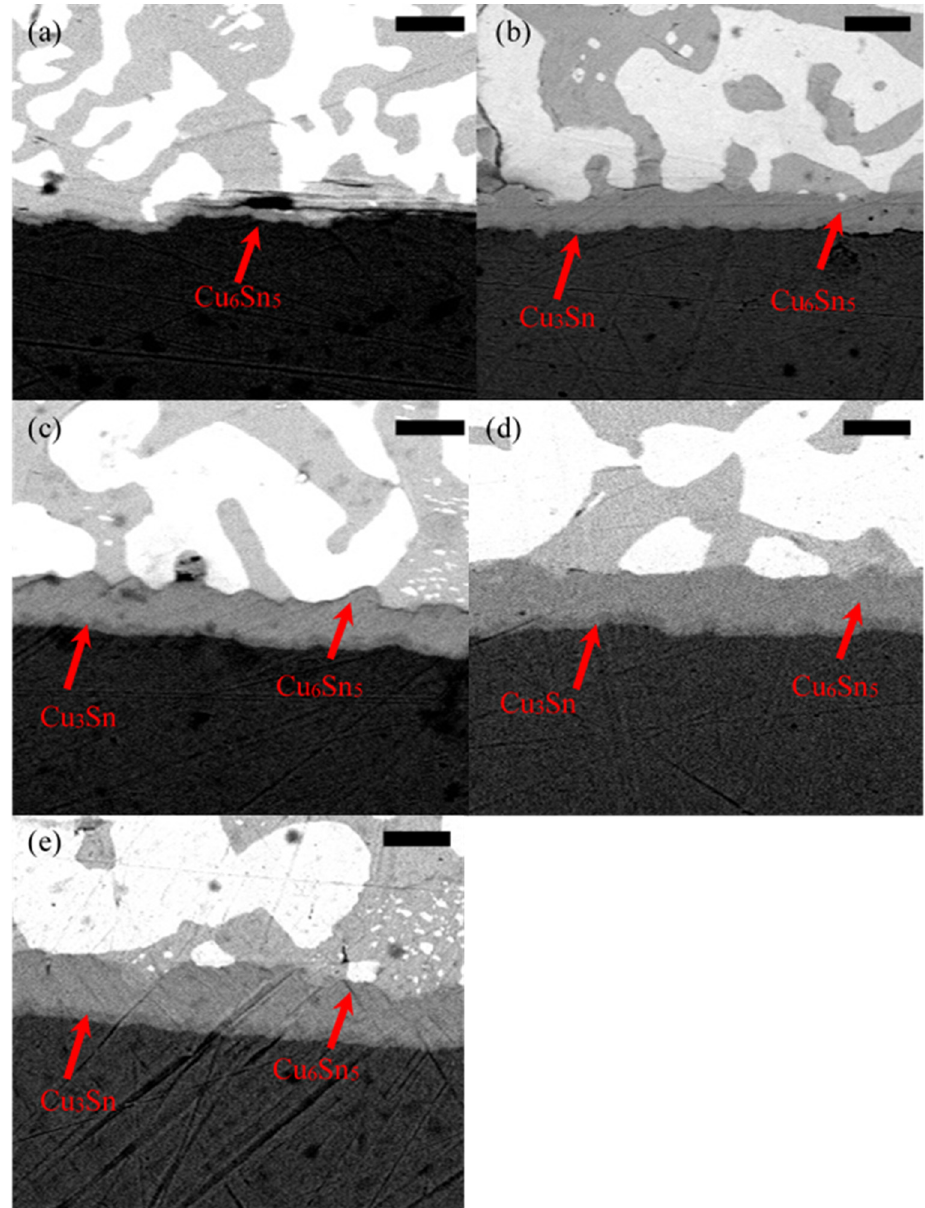
Figure 15. SEM micrograph of 42Sn57Bi1Ag after ( a ) 0 cycles, ( b ) 250 cycles, ( c ) 500 cycles, ( d ) 750 cycles and ( e ) 1000 cycles. The scale bar is 4 µm in all images.